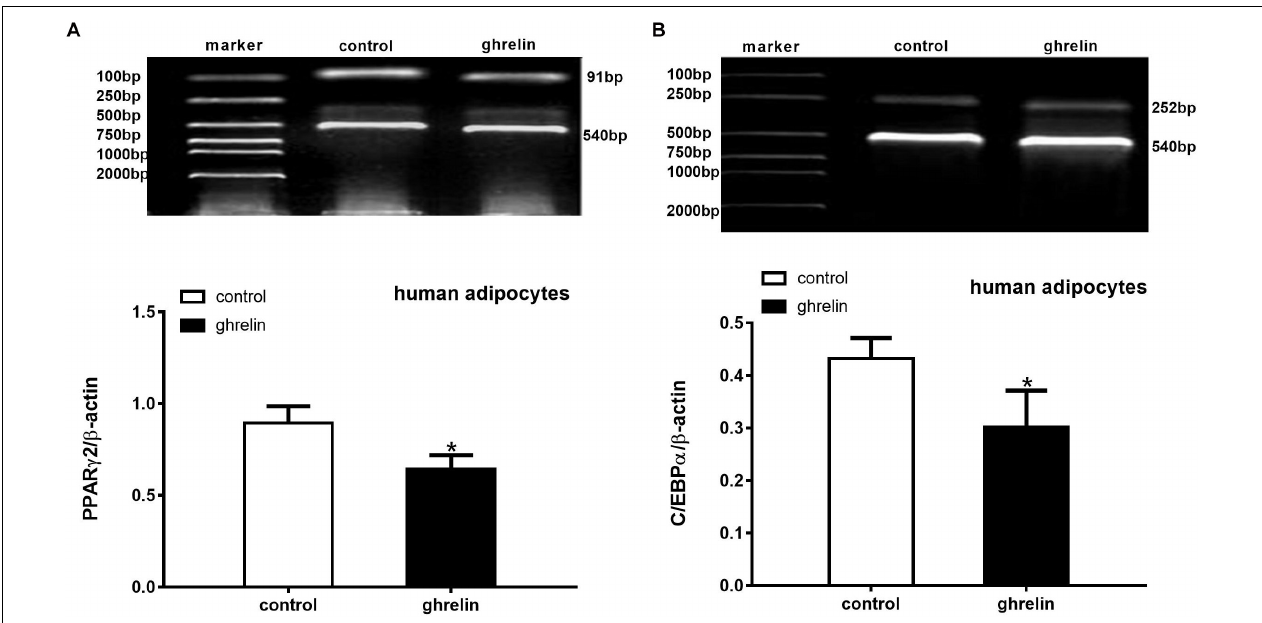
FIGURE 7 | Ghrelin suppressed the expression of PPAR γ 2 and C/EBP α mRNA in human differentiating adipocytes. Levels of PPAR γ 2 (A) and C/EBP α (B) mRNA in human differentiating adipocytes were measured using RT-PCR after treatment with 10 ng/ml ghrelin. The data are presented as the mean ± SD for three independent experiments. ∗ p < 0.05 vs. control